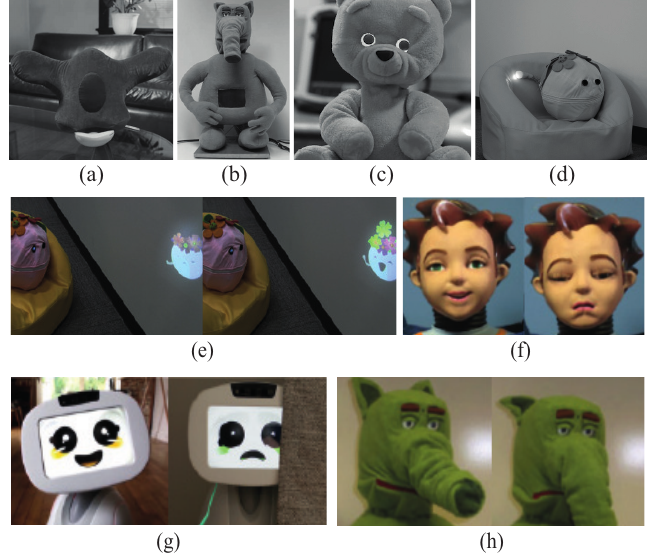
Figure 5. Photos used in the questionnaire to compare huggable robots according to the appearance: ( a ) The Hug; ( b ) Probo; ( c ) The Huggable and ( d ) Pepita. Photos used in the questionnaire to compare different robot’s emotional expressions. Expressions made by display: ( e ) Pepita and ( g ) Buddy. Expressions made by mechanical face: ( f ) Zeno and ( h )